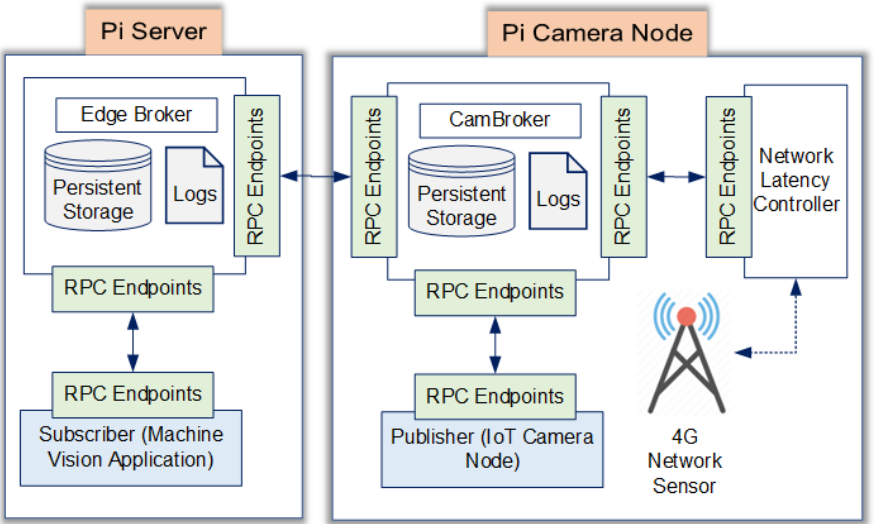
Figure 5. The Mez